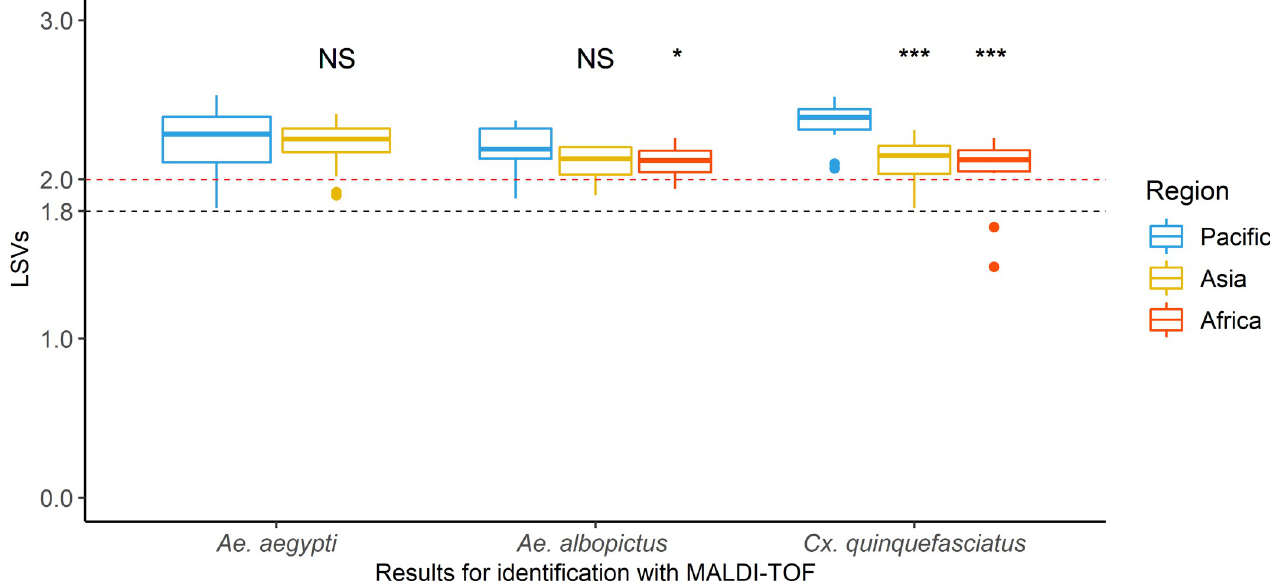
Fig 2. Identification scores of mosquitoes collected from the three regions when using the Pacific region MALDI-TOF database. Three mosquito species were analyzed: Aedes aegypti , Aedes albopictus and Culex quinquefasciatus . Colors illustrate the region of collection. Each boxplot consists of nine to 40 LSVs per species and per region. Black dashed-line corresponds to the threshold value for mosquito species identification, stated during previous study [29]. Red dashed-line corresponds to the threshold value for the identification of mosquito species belonging to the Scutellaris Group. Wilcoxon test, � p-value < 0.05, ��� p-value < 0.001. Abbreviation: NS, not significant.